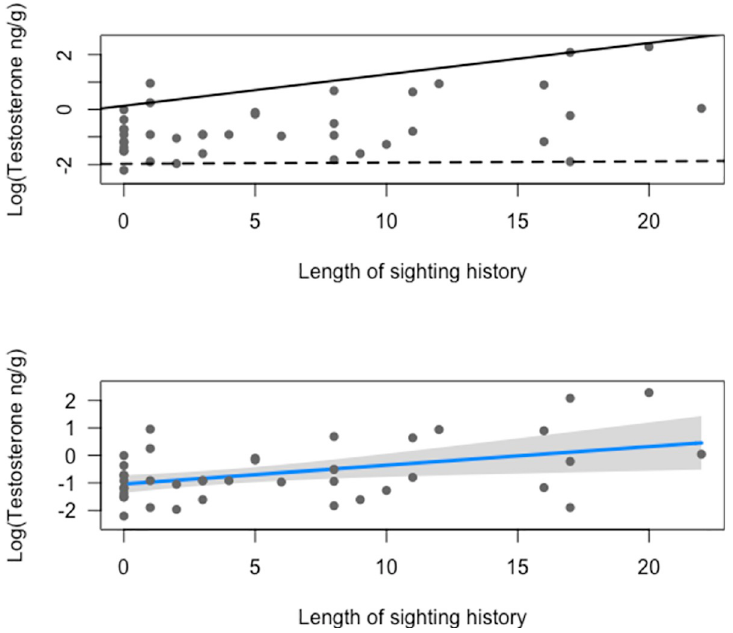
Fig 2. Median and mean log-transformed testosterone concentrations (ng/g) of gray whale males against length of sighting history (LSH). Top graph : quantile regression indicated significant increase in the median testosterone concentration in the 95 th percentile ( P < 0.001; solid line), but not in the 5 th percentile ( P = 0.9; dashed line); the analysis indicates that the highest levels of this hormone increase with age, but the lower concentrations do not. Bottom graph : linear regression with unequal variance indicated a significant increase of mean testosterone concentrations in response to LSH ( P = 0.03).